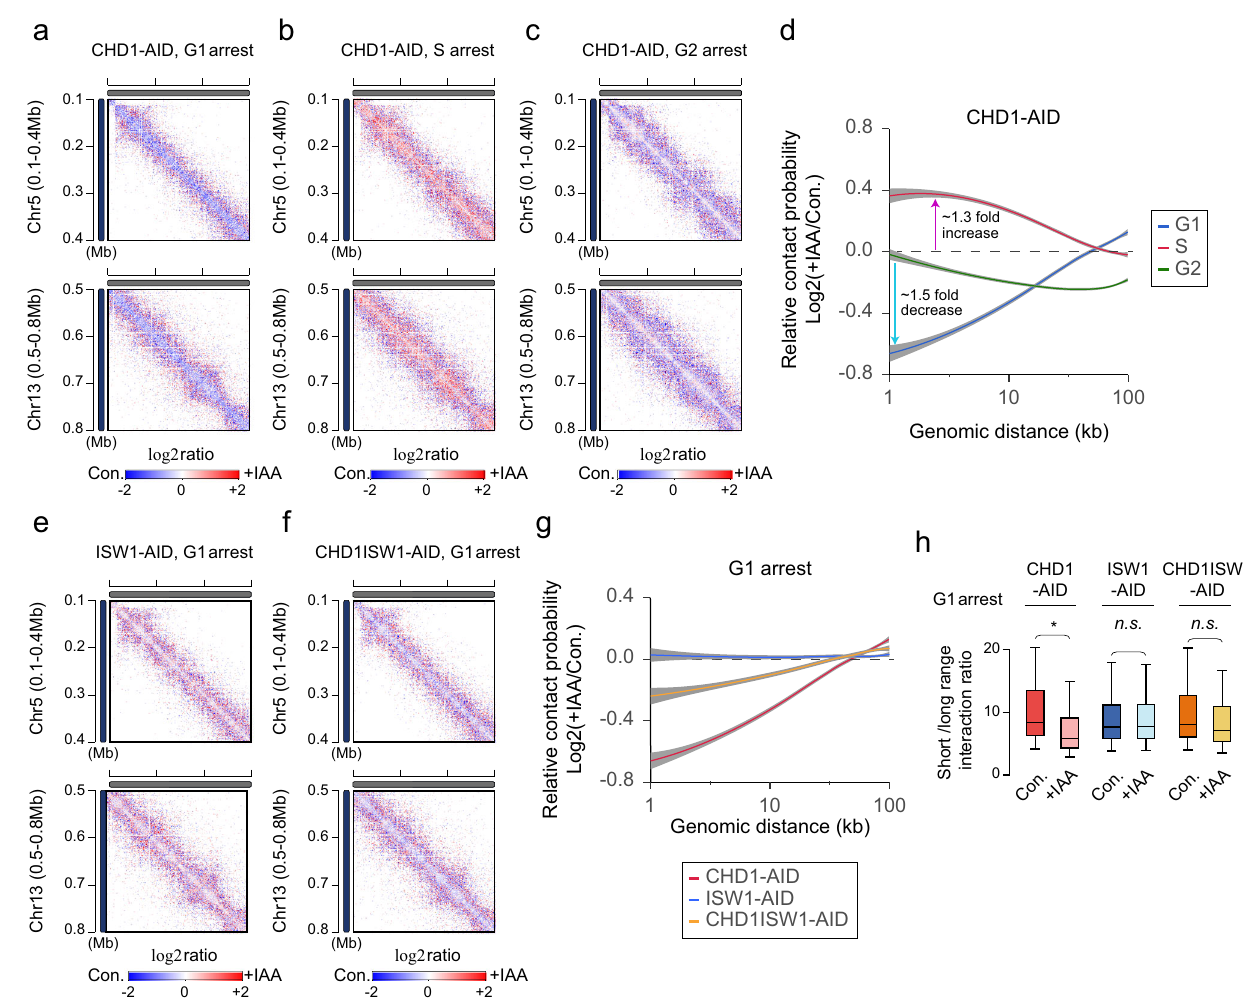
Fig. 2 The function of Chd1p in 3D genome organization is distinct from that of Isw1. a – c Zoom-in log 2 ratio contact map of chromosome 5 (0.1 – 0.4 Mb region; upper panel) and chromosome 13 (0.5 – 0.8 Mb region; lower panel) in CHD1-AID strain at G 1 , S, and G 2 phases, respectively. The 1-kb resolution matrices of control and knockdown samples were used for log 2 ratio calculations. d Log 2 ratio of the average contact probability (CP) along genomic distance between control (Con.) and IAA-treated ( + IAA) CHD1-AID strains at G 1 , S, and G 2 phases. The gray shadow indicates the con fi dence interval around smooth (se). e , f Same as described for a but in ISW1-AID and CHD1ISW1-AID strains at G 1 phase. g Log 2 ratio of the average contact probability (CP) along genomic distance between control (Con.) and IAA-treated ( + IAA) CHD1-AID, ISW1-AID, and CHD1ISW1-AID strains at G 1 phase. The gray shadow indicates the con fi dence interval around smooth. h Comparison of the short-versus-long range interaction (SVL) ratio per chromosome ( n = 16) relative to 100 kb in CHD1-AID, ISW1-AID, and CHD1ISW1-AID strains at G 1 phase. The p -values were calculated using a one-sided Wilcoxon rank-sum test (*<0.05 and n.s. means not signi fi cant, the p -value of CHD1-AID; 0.041). Boxplot show median; box limits, upper and lower quartiles;